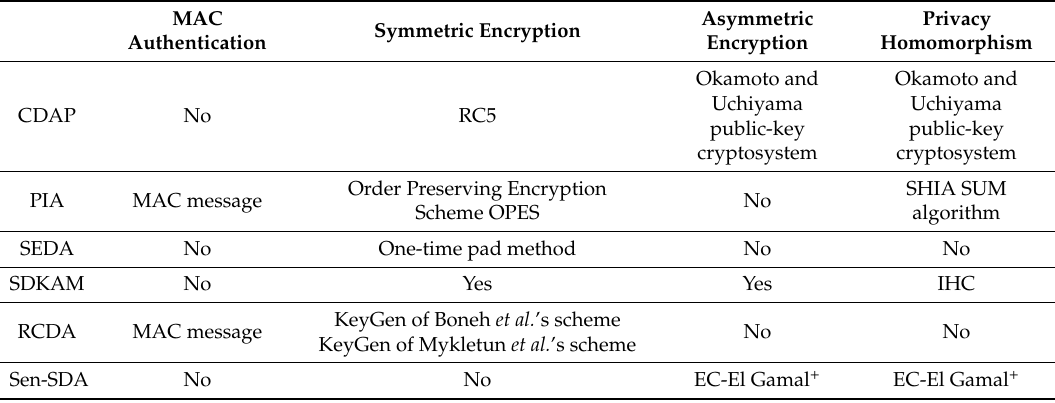
Table 2. Security primitives of the heterogeneous end to end data aggregation security